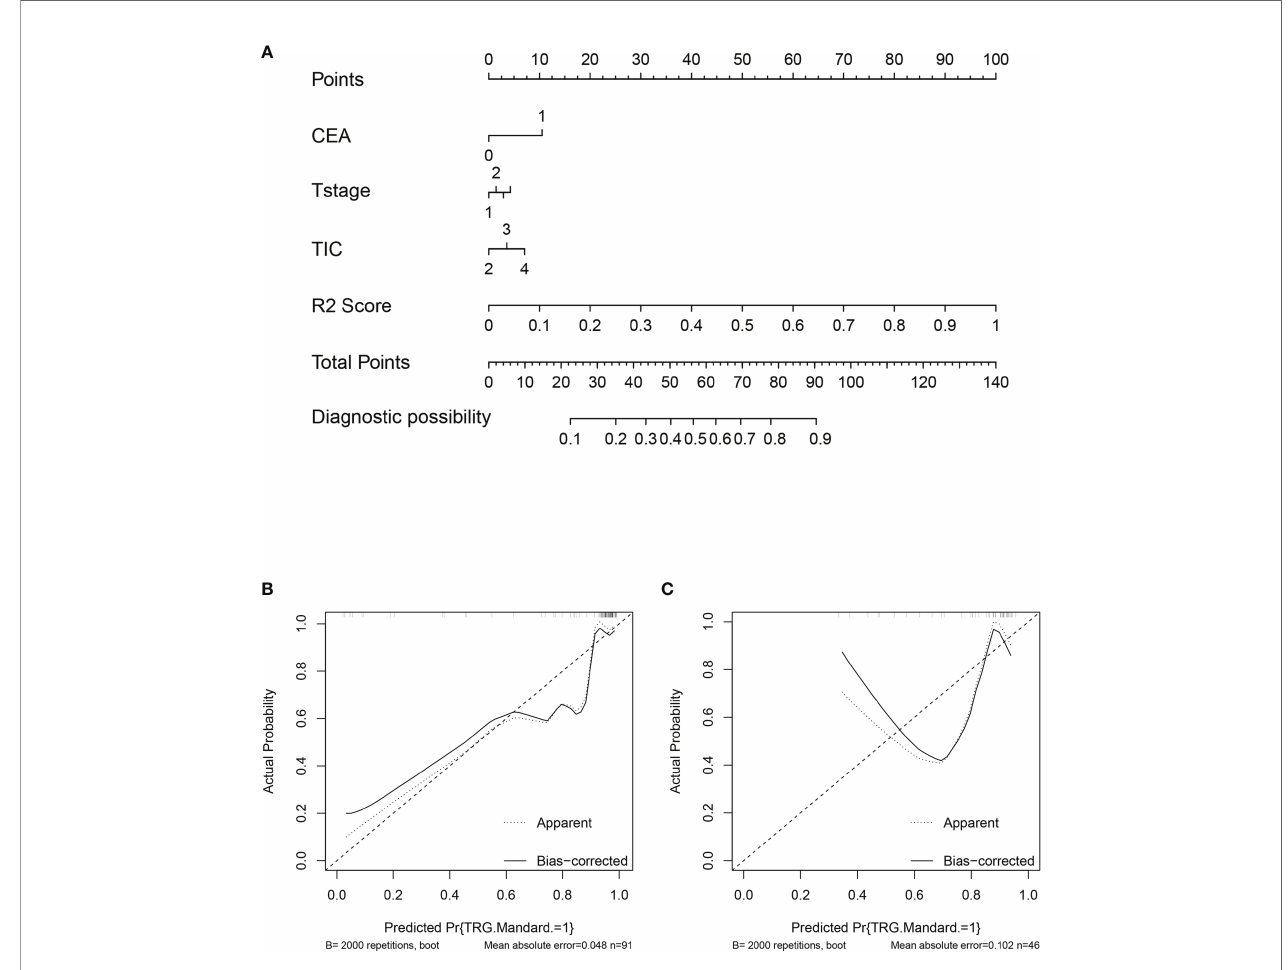
FIGURE 5 | Nomogram based on the clinical characteristics and intratumor radiomics features in the prediction of response to neoadjuvant chemotherapy in locally advanced rectal cancer (LARC). (A) Nomogram based on clinical features and intratumor radiomics. (B) The calibration curve for intratumor radiomics and clinical features in predicting treatment response for LARC in the training set. (C) The calibration curve for intratumor radiomics and clinical features in predicting treatment response for LARC in the validation